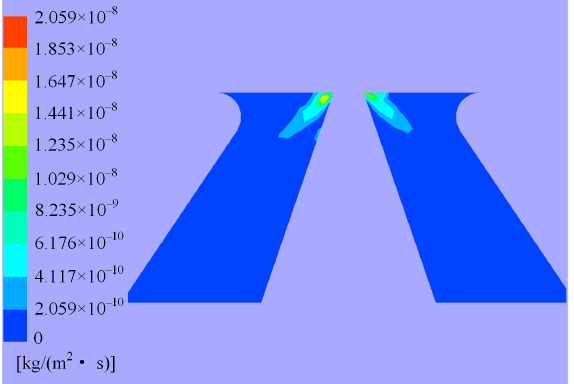
Figure 10. Erosion rates of upper surface of the receiver.